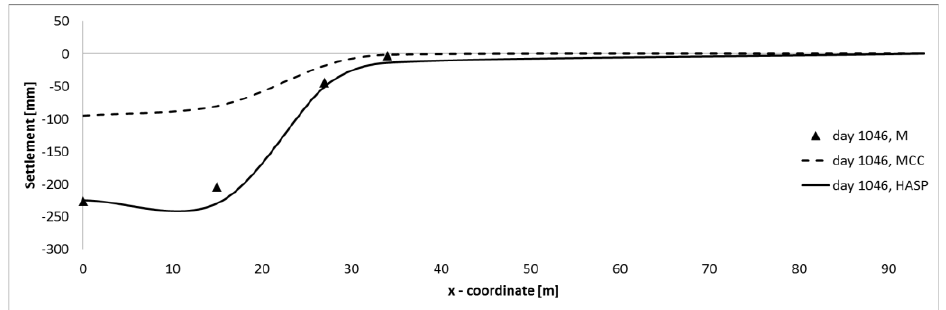
Figure 24. Comparison of the settlement of the ground surface for Embankment B — day 1046.